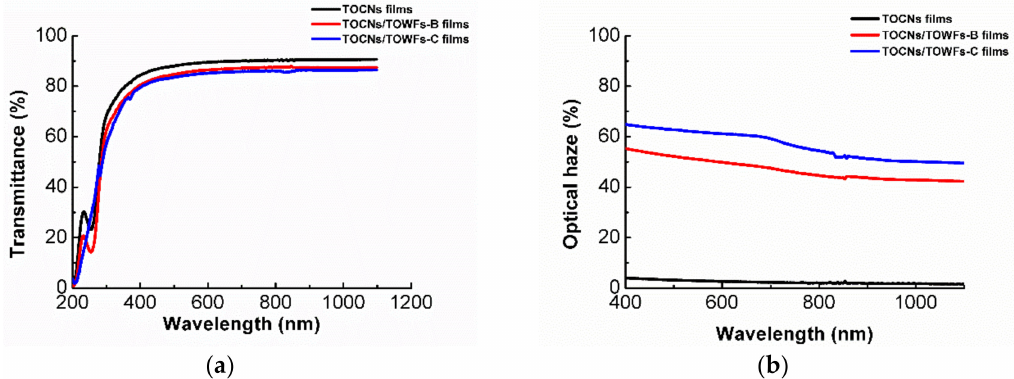
Figure 2. ( a ) Transmittance of TOCN films, TOCNs/TOWFs-B films, and TOCNs/TOWFs-C films and ( b ) Optical haze of TOCN films, TOCNs/TOWFs-B films, and TOCNs/TOWFs-C films. Transparency is a significant optical parameter for most transparent electronic devices